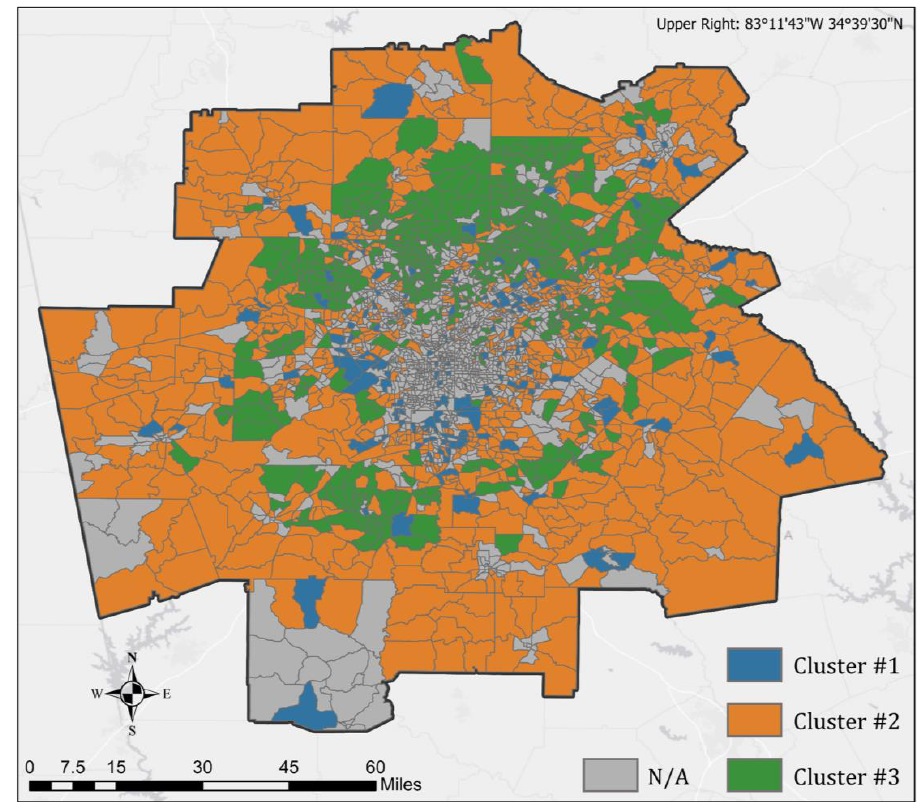
Figure 5. The spatial distribution of the three identified CBG clusters.